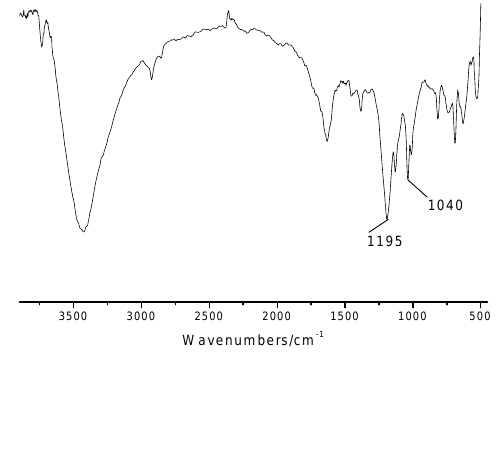
Figure 2. The IR spectrum of the novel